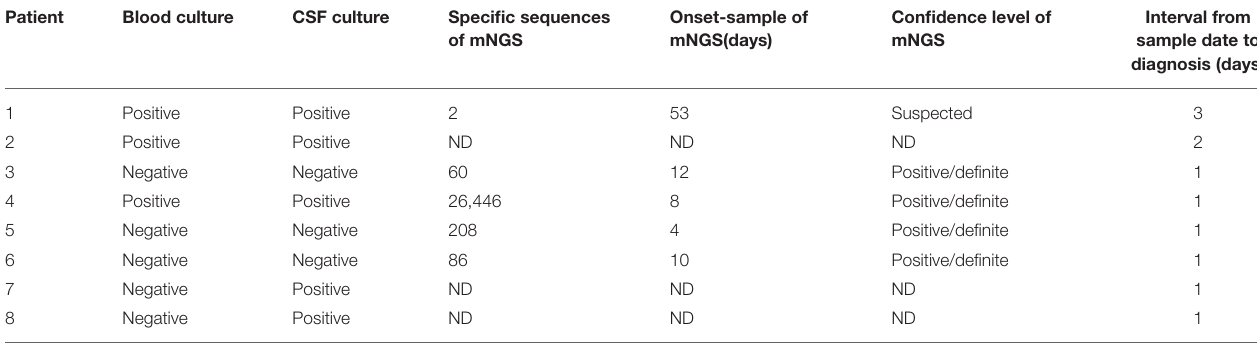
TABLE 3 | Summary of the microbiological investigations in the patients. Patient